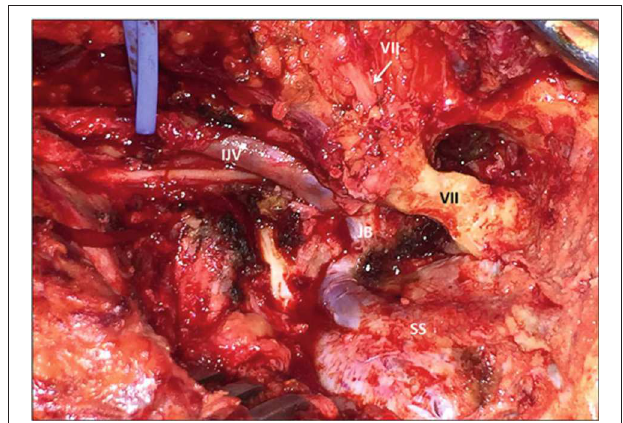
FIGURE 15 | Jugular foramen opened after neck dissection, radical mastoidectomy and retrosigmoid craniectomy (3). IJV, internal jugular vein; JB, jugular bulb; TU, tumor; SS, sigmoid sinus; VII, facial nerve in the fallopian canal (black) and entering the parotid gland (white). [Modified from Ramina and Tatagiba